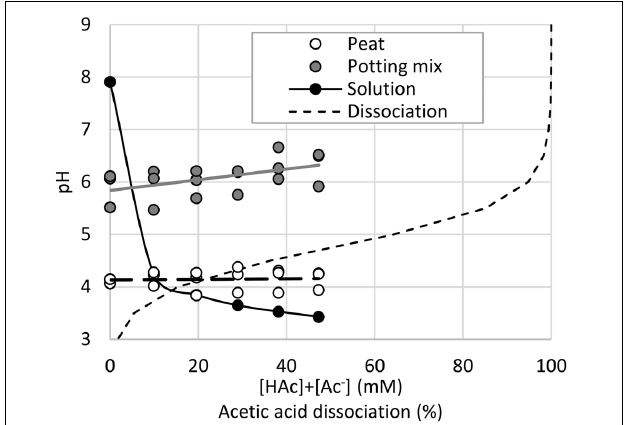
FIGURE 4 | pH of a range of total (undissociated and dissociated) acetic acid ([HAc] + [Ac − ]) irrigation solutions and the resulting pH of treated seedling peat and potting mix growth media ( n = 3), fitted with a linear regression, along with the expected dissociation of acetic acid at 25 ◦ C.